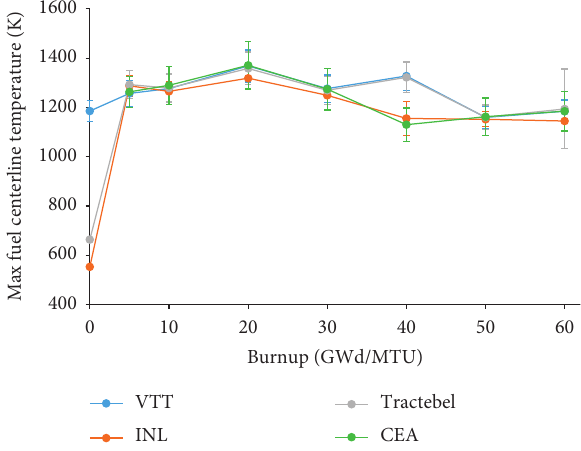
Figure 13: PWR depletion test case based on TMI-1 fuel rod